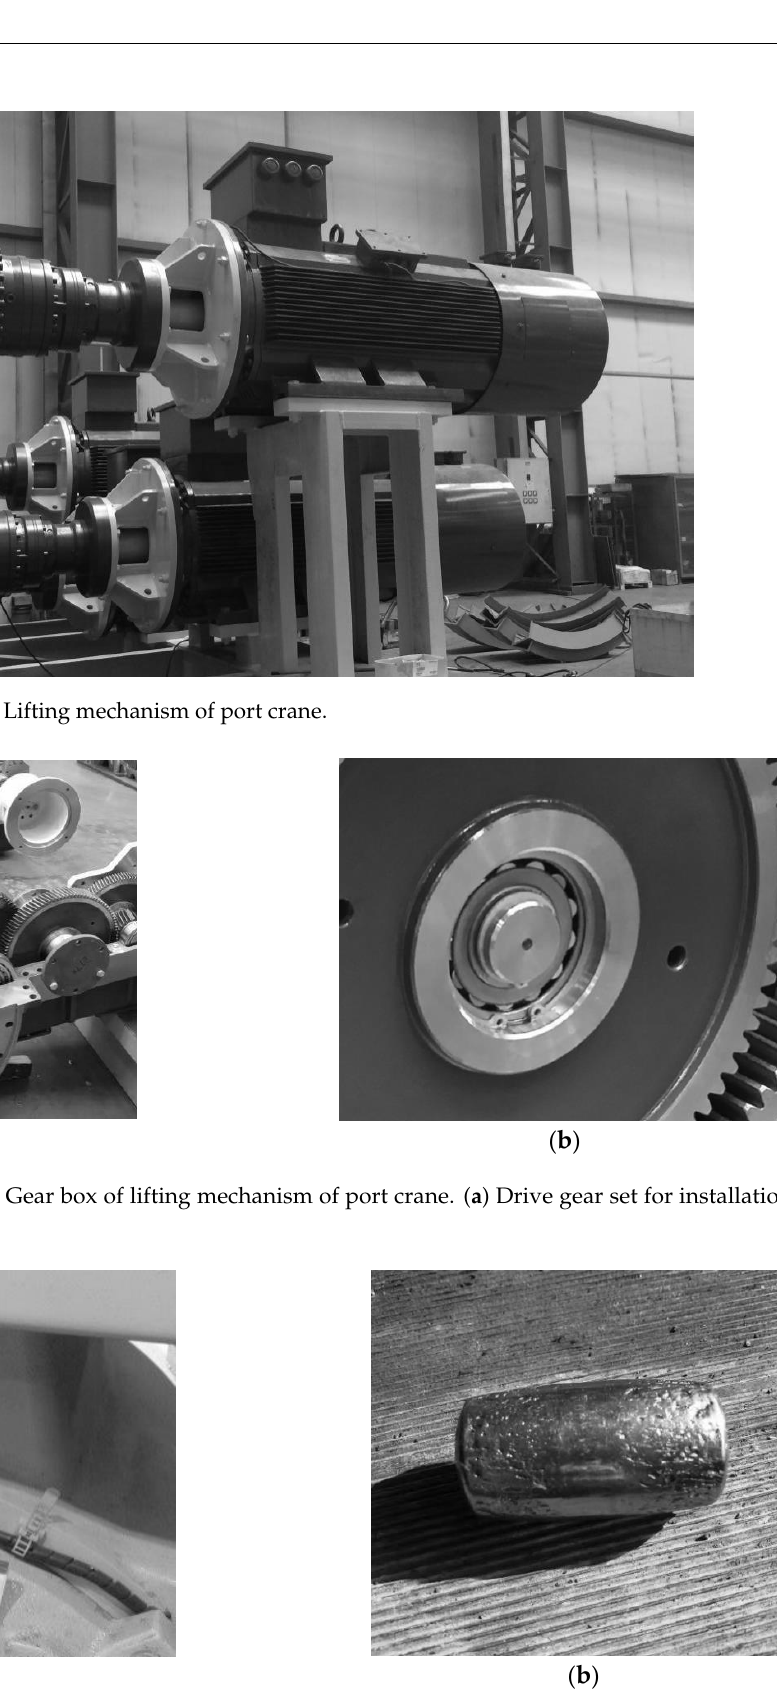
Figure 7. Experimental settings. ( a ) Installation position of vibration sensor. ( a ) Installation position of vibration sensor.